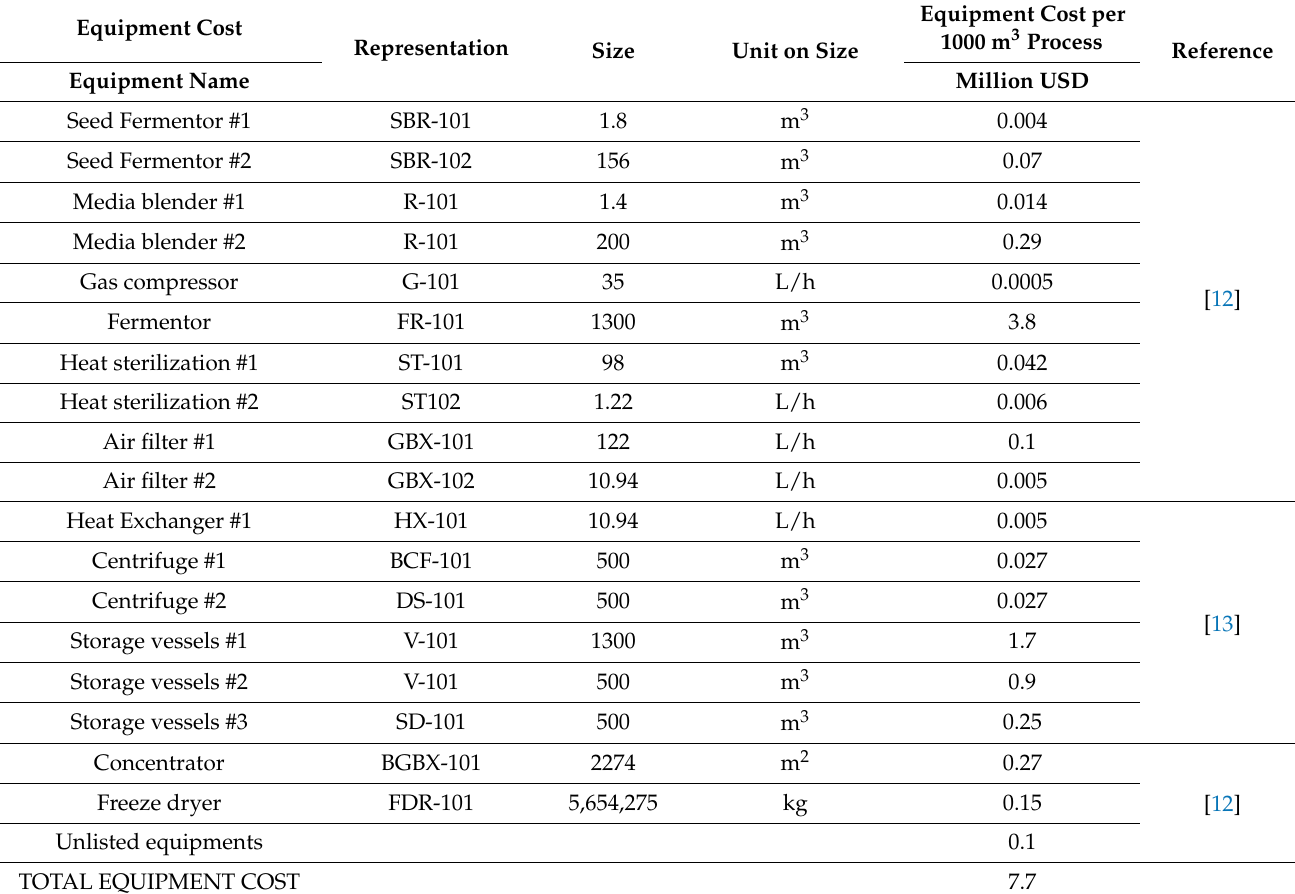
Table 6. List of equipments involved in the submerged production of cellulases in 1000 m 3